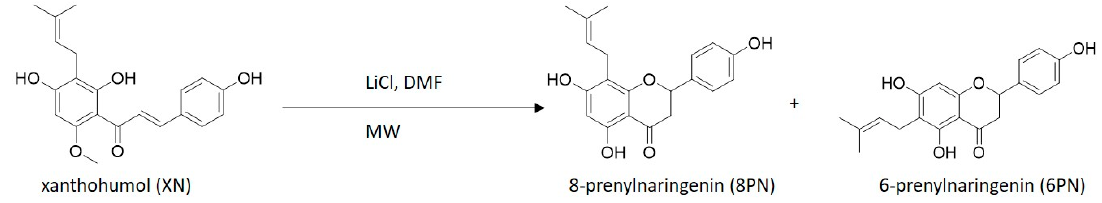
Figure 2. Demethylation of xanthohumol (XN) to 8-prenylnaringenin and 6-prenylnaringenin (6PN) using lithium chloride (LiCl), dimethylformamide (DMF), and microwave irradiation (MW).